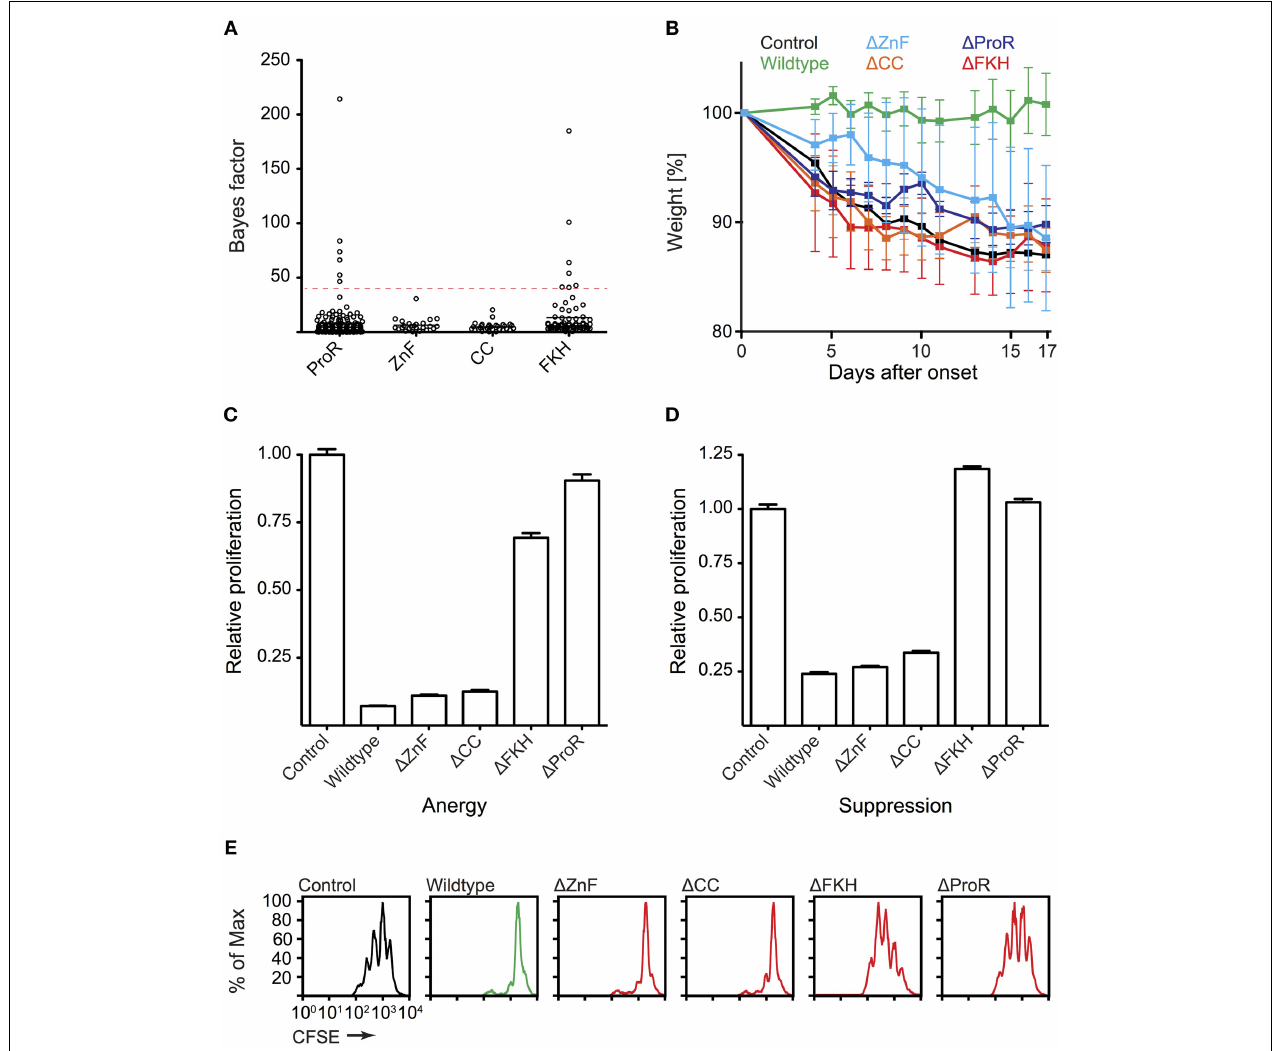
cells was measured by following the mean weight of the mice ( n ≥ 4 per group) normalized to their weight on the day of onset in control mice. (wildtype vs. mutants: P ≤ 0.001 in each case; one-way ANOVA). (C–E) Suppressive activity and induction of anergy (non-proliferation) in the transducedT cells as shown by the relative proliferation normalized to that of control transduced cells of (C) “target”T cells or (D) transducedT cells. (E) Representative CFSE-profiles of “target”T cell proliferation. Error-bars represent the